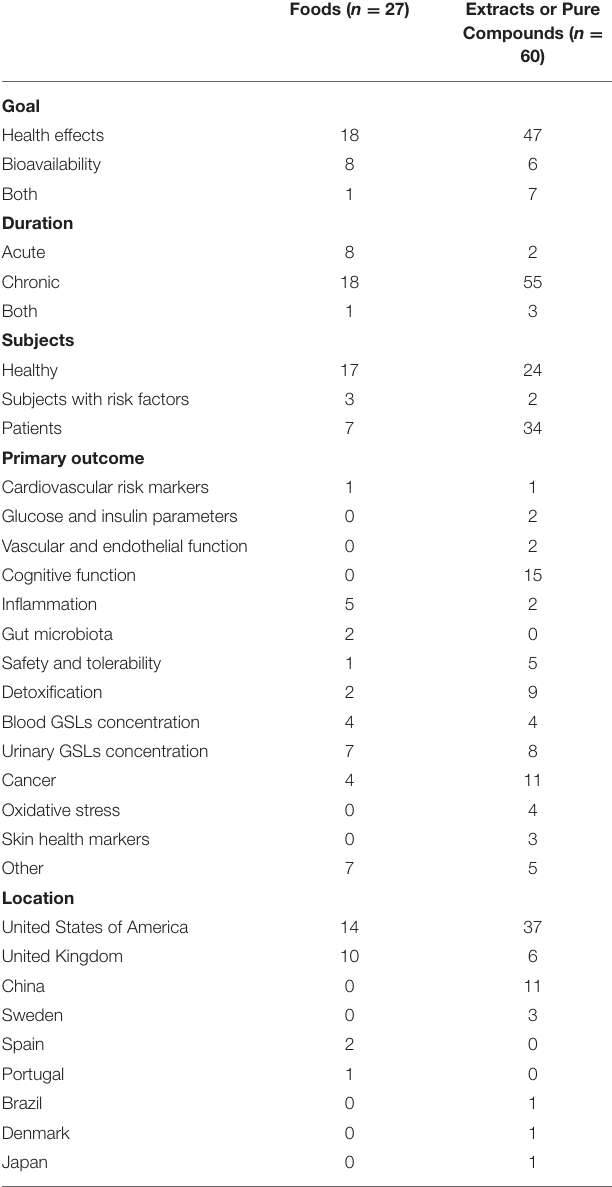
TABLE 1 | Population, intervention, comparison, outcome, study design (PICOS) criteria for trial selection cited. Parameter